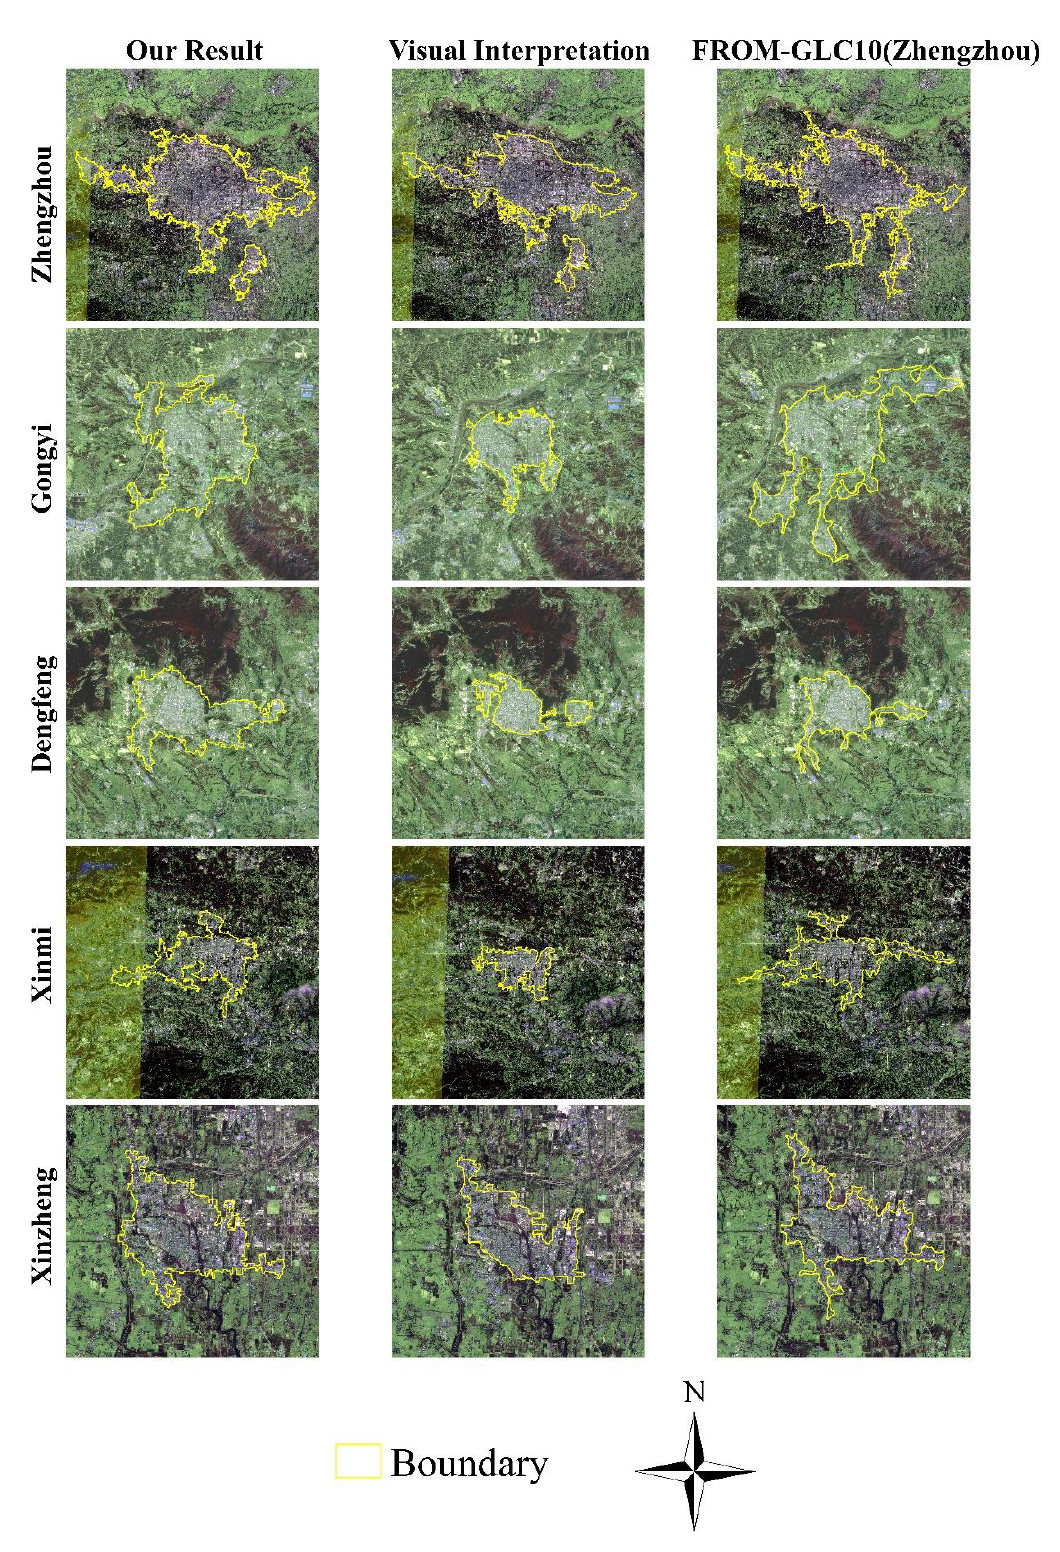
Figure 11. Comparison of different research results on delineation urban boundaries.